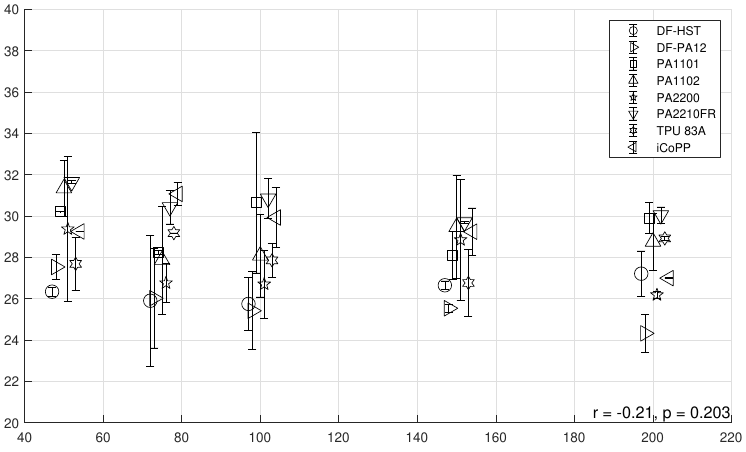
Figure 6. Powder layer density PLD vs. recoating speed v